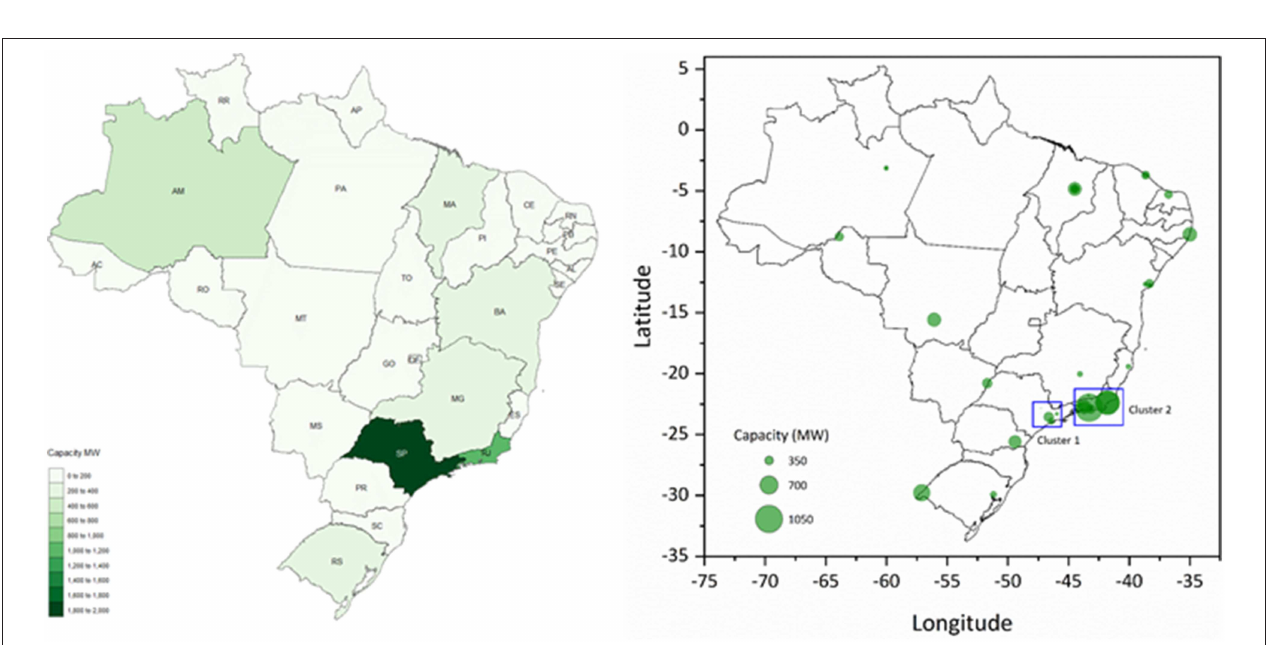
FIGURE 6 | Annual emissions of 20 Brazilian Power Plant (natural gas) with higher installed capacity (RJ, Rio de Janeiro; RS, Rio Grande do Sul; AM, Amazonas; PE, Pernambuco; MT, Mato Grosso; MA, Maranhão; PR, Paraná; RO, Rondônia; SP, São Paulo; MS, Mato Grosso do Sul; BA, Bahia; CE, Ceará; RN, Rio Grande do Norte).